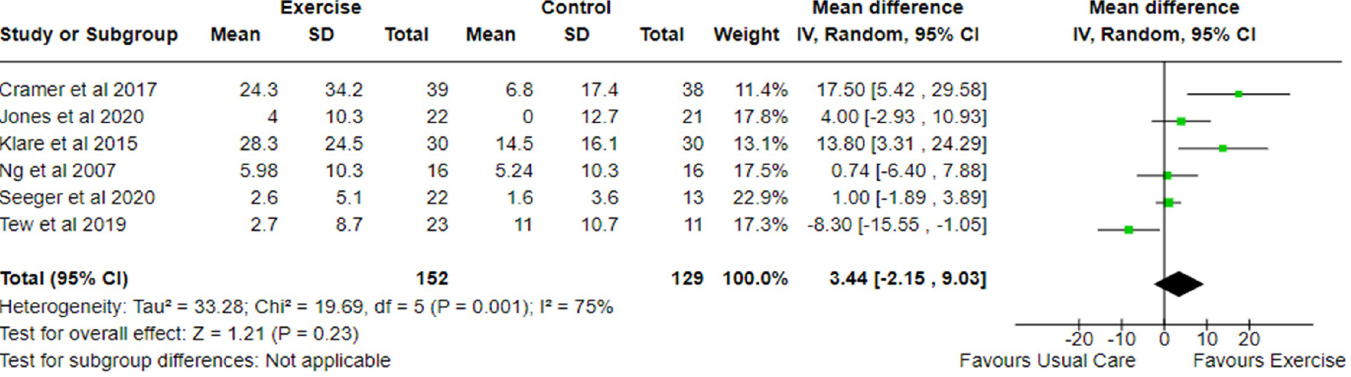
Fig 3. Meta-analysis of change in QOL following an exercise intervention in adults with IBD using the IBDQ. SD, Standard Deviation; Std, Standard; IV, Weight Mean Difference; CI, Confidence Interval; IBDQ, Inflammatory Bowel Disease Questionnaire.